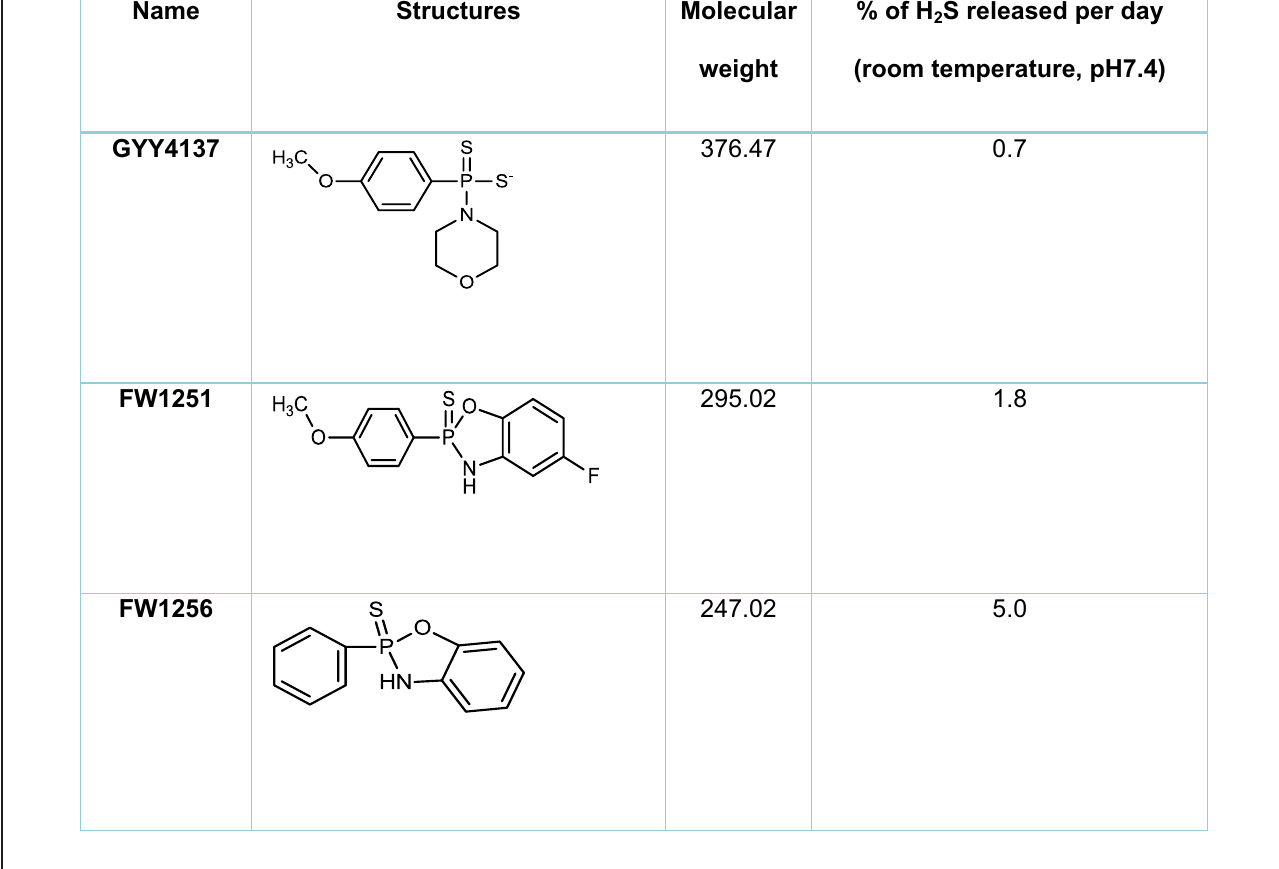
Table 1. Chemical structures and H 2 S releasing speeds of H 2 S donor compounds used in this study compared to GYY4137.